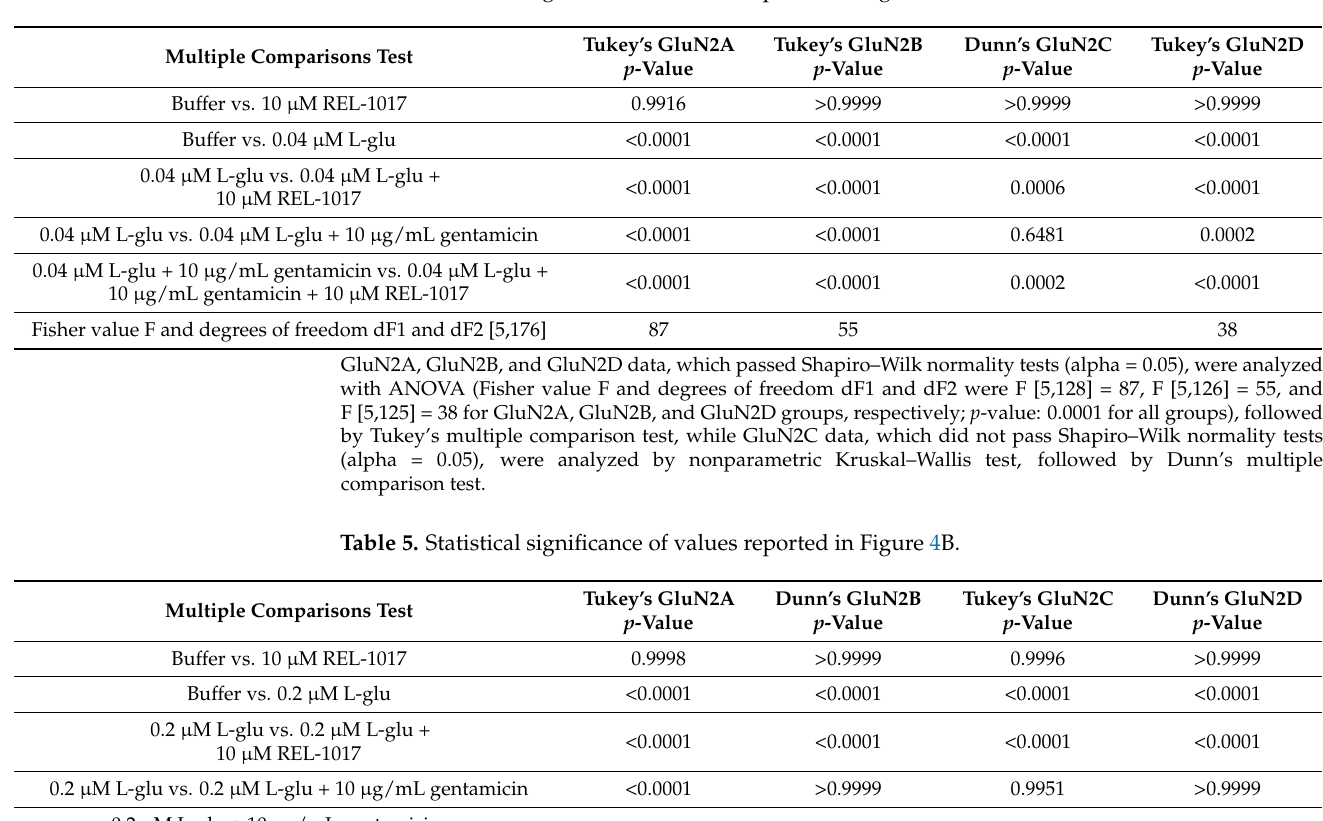
Table 4. Statistical significance of values reported in Figure 4A.